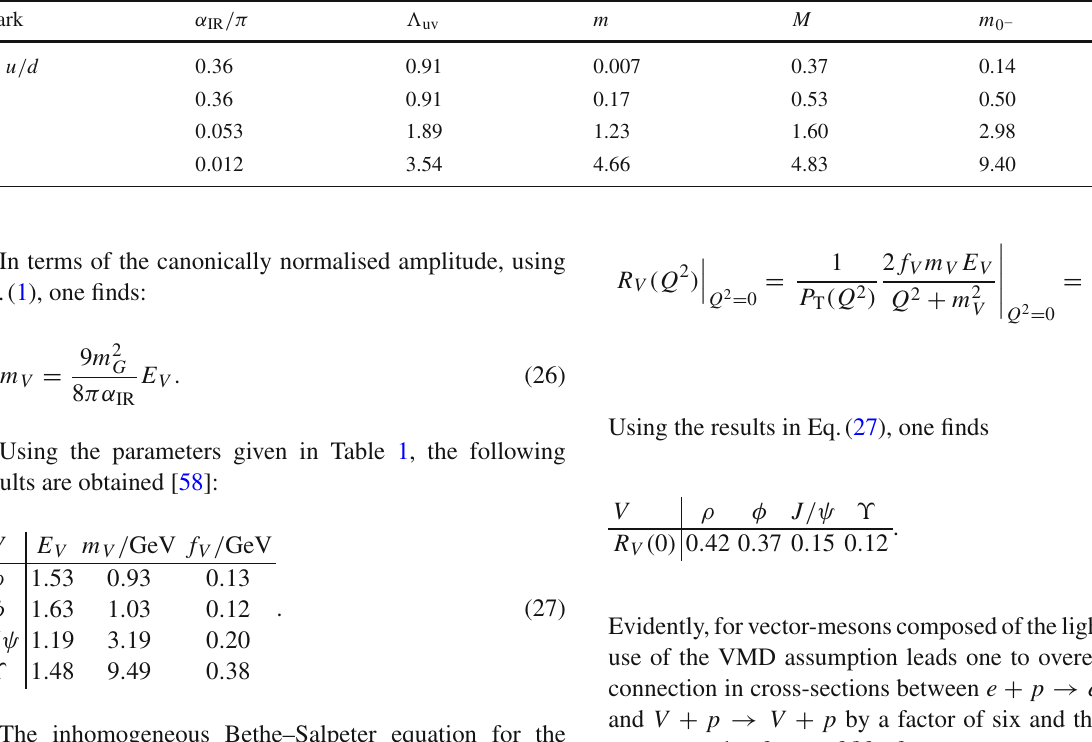
tified quark and M is the associated dressed-quark mass obtained by solving the gap equation. Empirically, at a sensible level of precision [61]: m π = 0 . 14, f π = 0 . 092; m K = 0 . 50, f K = 0 . 11; m η